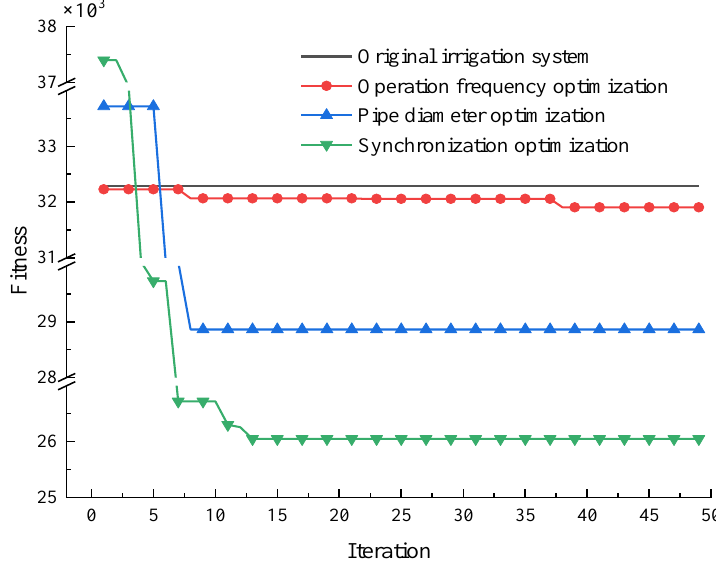
Figure 8. Iterative graph of cost for different optimization models.